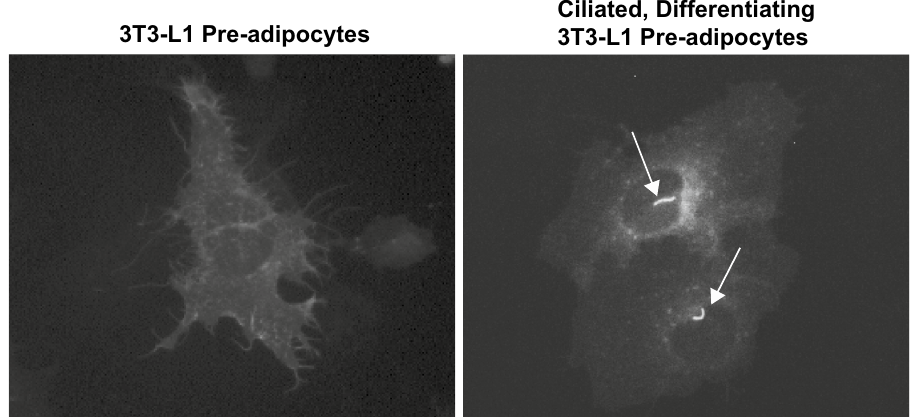
Figure 1. MCH receptor 1 localizes to different membrane structures in 3T3-L1 preadipocytes. 3T3-L1 preadipocytes were transiently transfected with MCHR1-eYFP in 35 mm dishes on coverslips. Some dishes were initiated to differentiate for 2 Days (right panel). All cells were fixed with 4% paraformaldehyde. MCHR1- positive putative cilia are indicated with arrows (right